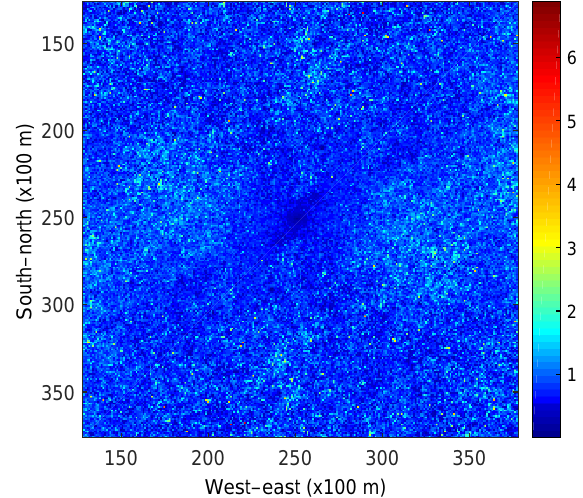
Figure 5. Semivariogram map ( ˆ γ(h x ,h y ) ) of the normal score transformed sediment thickness Z D ; grid cells of 100 ×